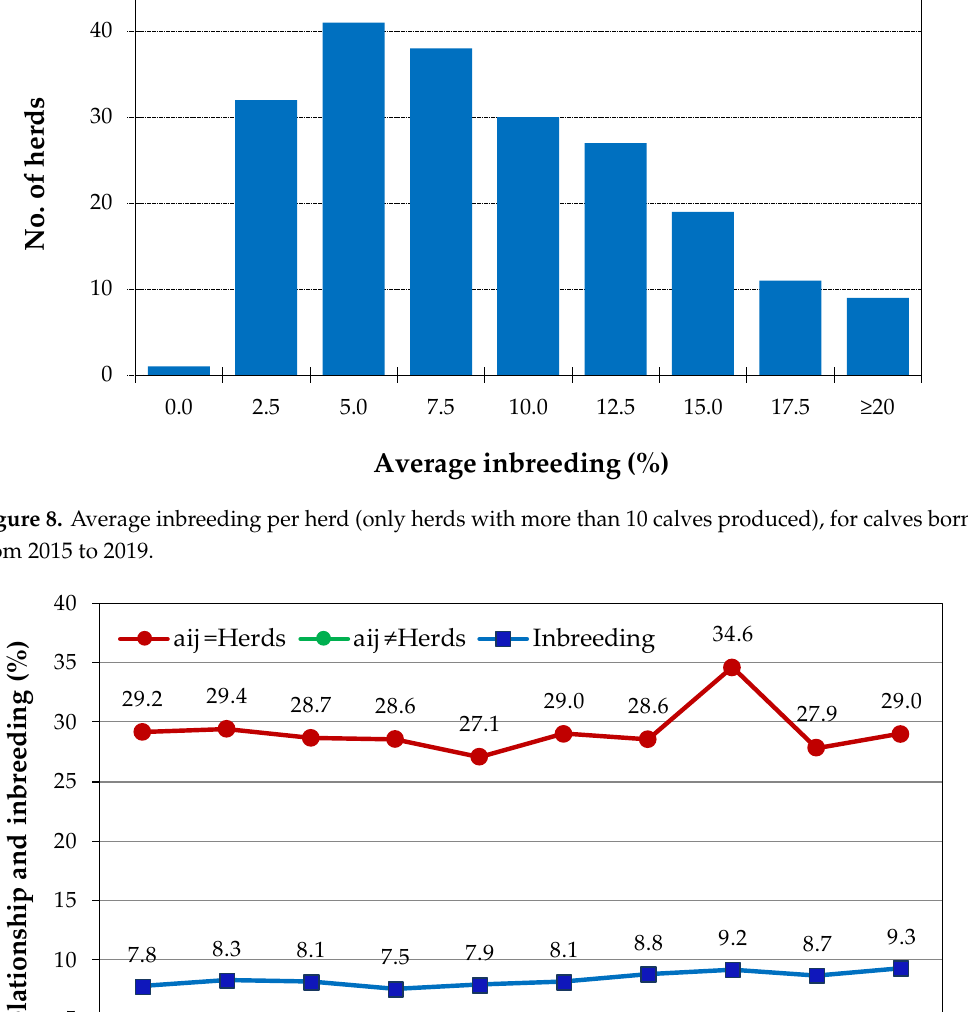
Figure 8. Average inbreeding per herd (only herds with more than 10 calves produced), for calves born from 2015 to 2019.